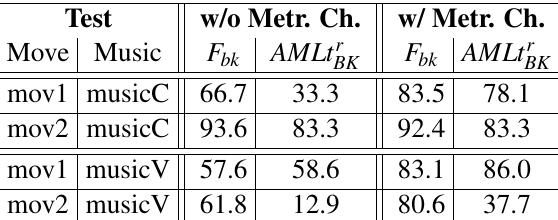
Table 1: Mean beat-synchrony results, F (in %), for the eight evaluated tests assessed in Fig. 6 and Fig. 7, with and without metrical-level